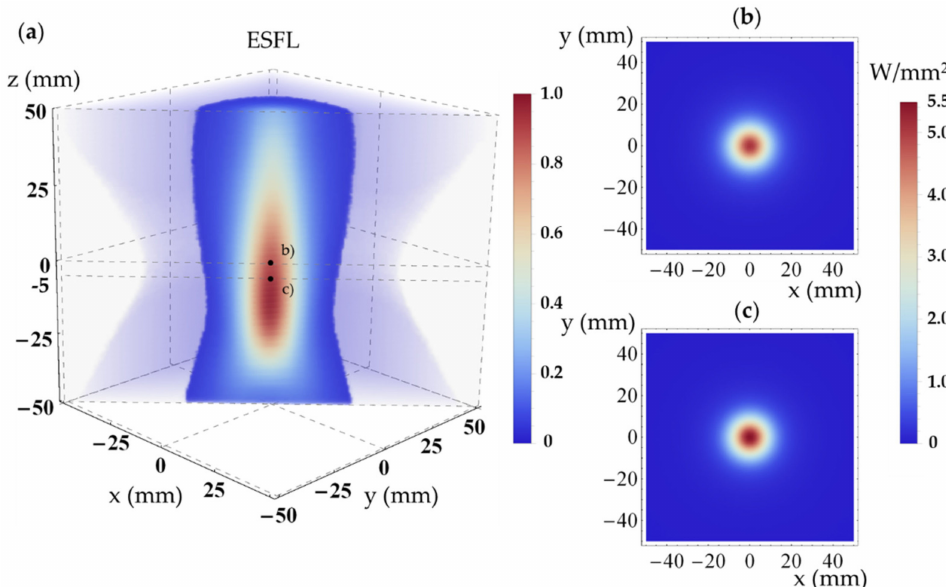
Figure 17. ( a ) Three-dimensional focal distribution of the ESFL. ( b ) Top view of the light distribution at the focal point (Z = 0 mm). ( c ) Top view of the light distribution with the highest concentrated solar flux (Z = − 5 mm).